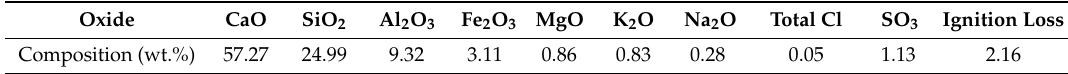
Figure 2. Detailed experimental configurations for the modified electrode configuration (MEC)